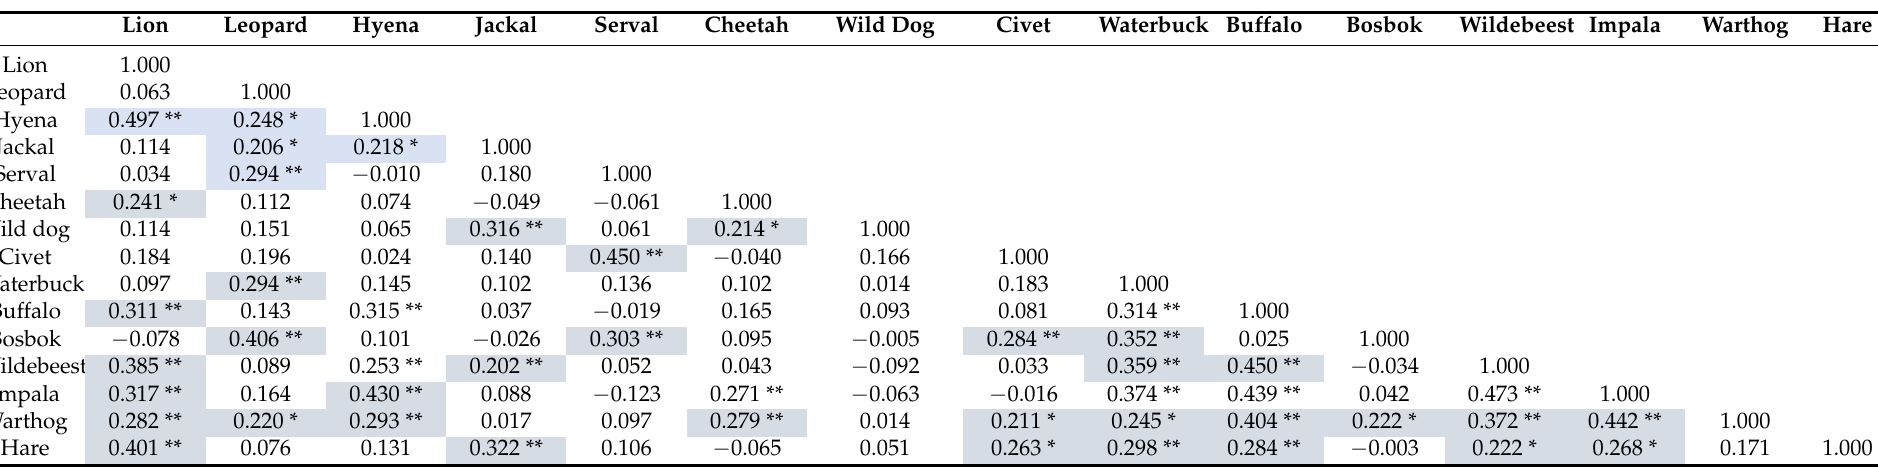
Table 2. Spearman’s rho rank correlation between carnivore species and herbivore detection rates (detections per day) based on camera trap data collected from two protected areas in Mpumalanga Province, South Africa for the years